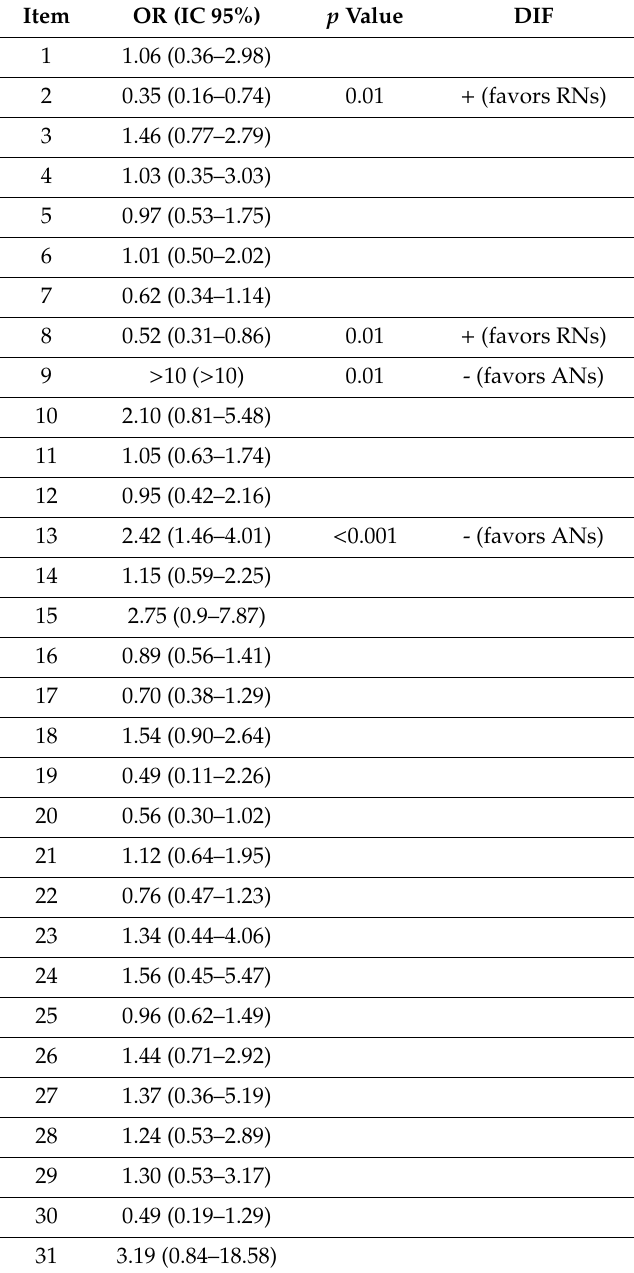
Table 4. Analysis of di ff erential item functioning for the PIPK questionnaire comparing RNs versus ANs.